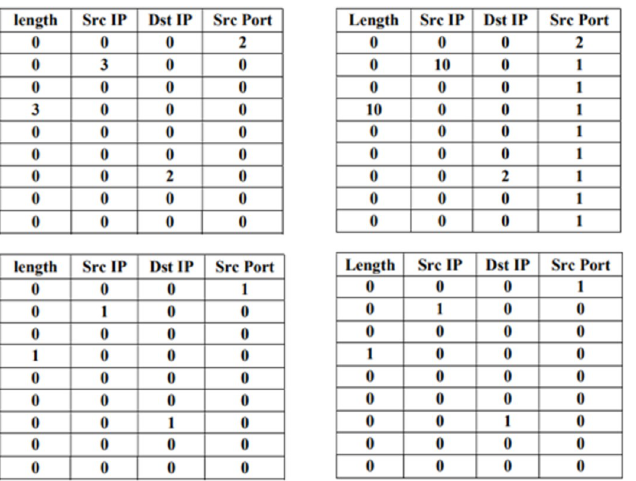
Fig 3. Simple example expressing a counter table growth overtime for ten consecutive packets with four header fields.